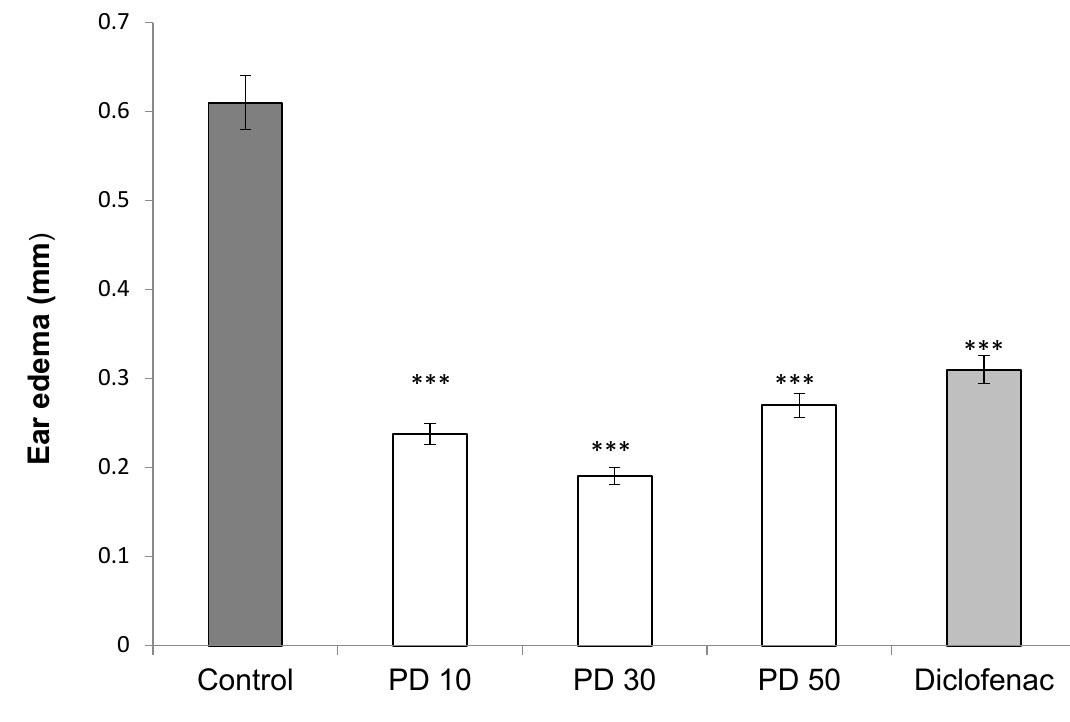
Figure 5. The effect of P. dermoporus polysaccharides on the croton oil-induced ear edema assay in BALBc mice. The animals were treated with 10 mg/kg (PD 10), 30 mg/kg (PD 30) and 50 mg/kg (PD 50) of P. dermoporus polysaccharides . Data obtained from animal experiments are expressed as the mean ± SD. The differences between treatment and control were tested by ANOVA. A value of (***) p < 0.001 was considered statistically significant.